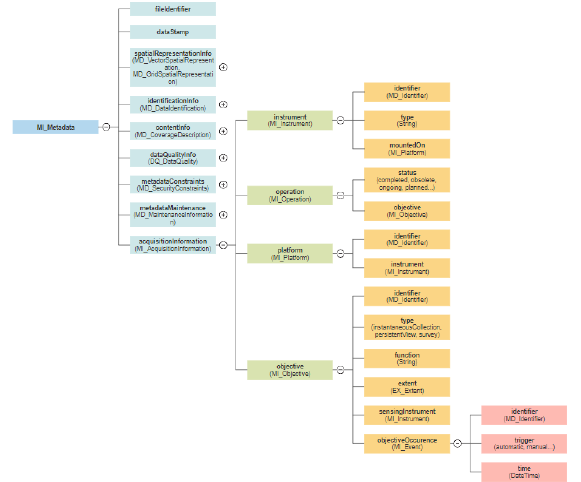
Figure 3. Organisation of acquisitionInformation attribute A big concern is recognised as the lack of representation in positioning a sensor – a prominent factor required for integration with spatial models. This inevitably raises issues into how and where to locate the device.